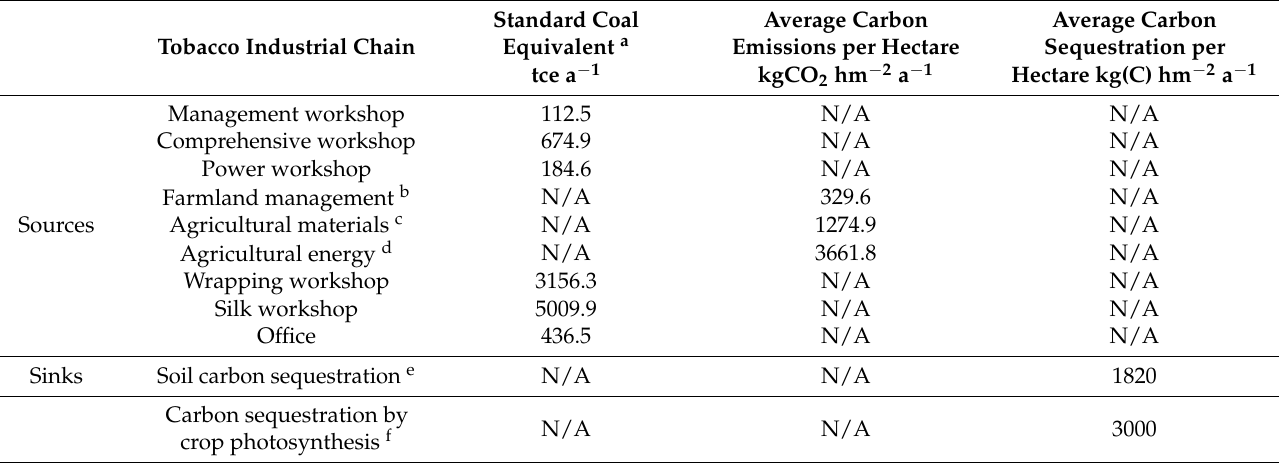
Table 1. The data of the case study.